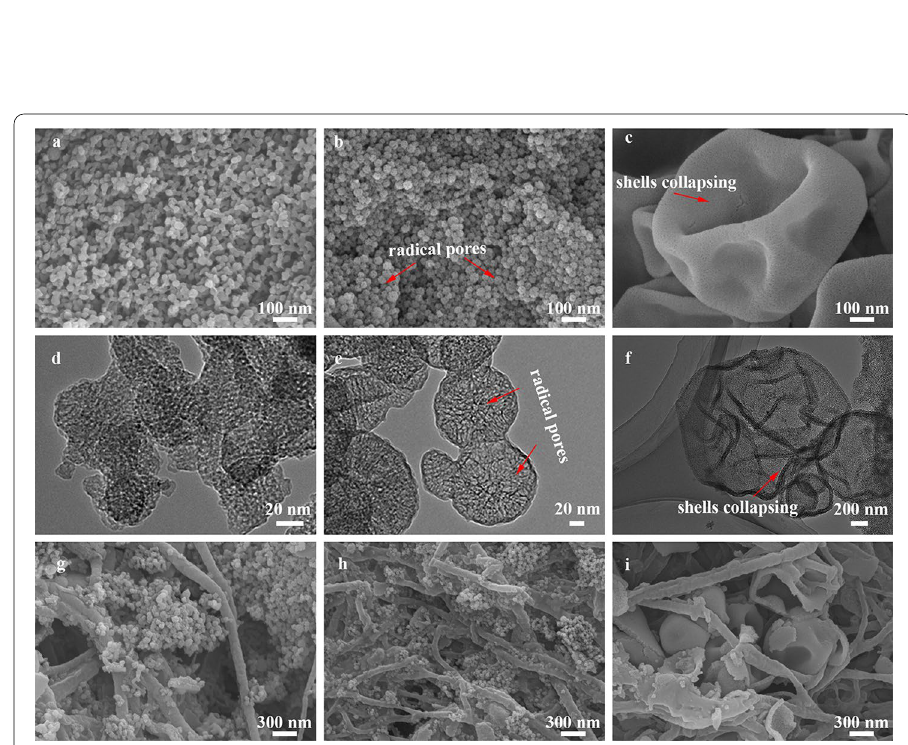
Fig. 3 SEM and TEM images of silica a , d C-SiO 2 -1; b , e C-SiO 2 -2; c , f C-SiO 2 -3. SEM images of silica/PM, g